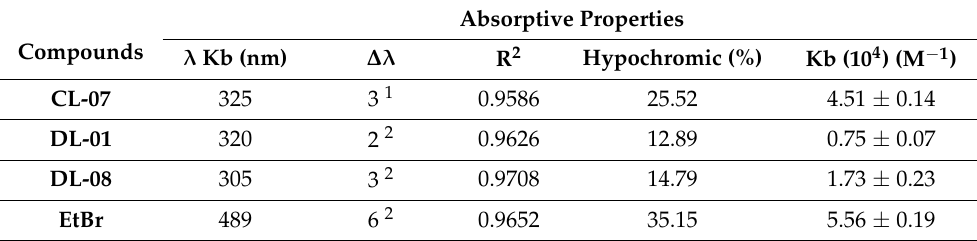
Table 4. Absorptive properties of derivatives and EtBr in the presence of CT